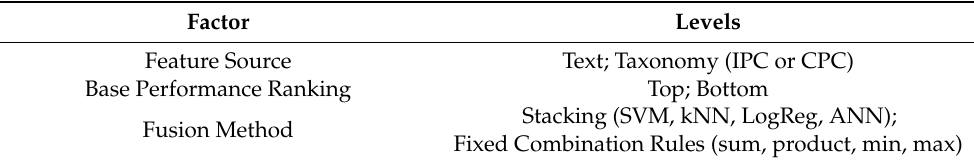
Table 4. Factors of the experimental design to build the varying classifier ensembles. Factor Levels Feature